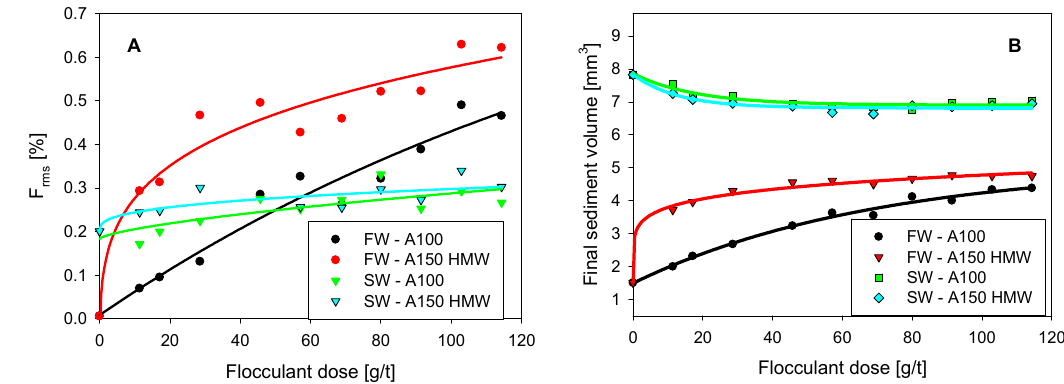
Figure 9. ( A ) Signal values F rms and ( B ) final sediment volume at varied flocculant dose (A150 HMW and A100) in the settled bed at pH 7.5 for distilled water (FW) and seawater